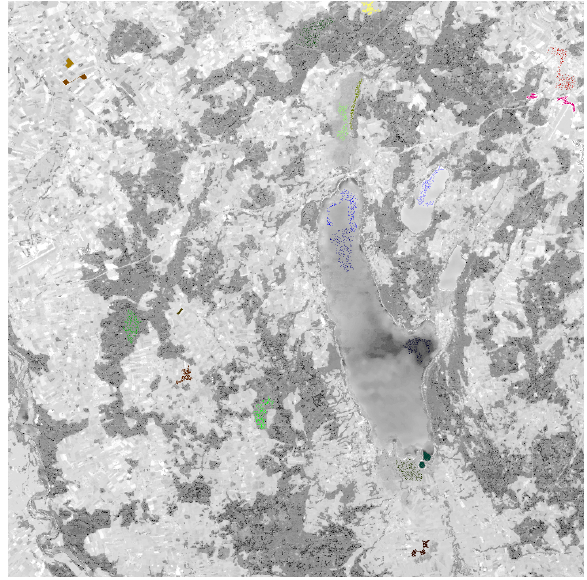
Figure 2. Location of labelled data within the simulated EnMAP dataset from Figure